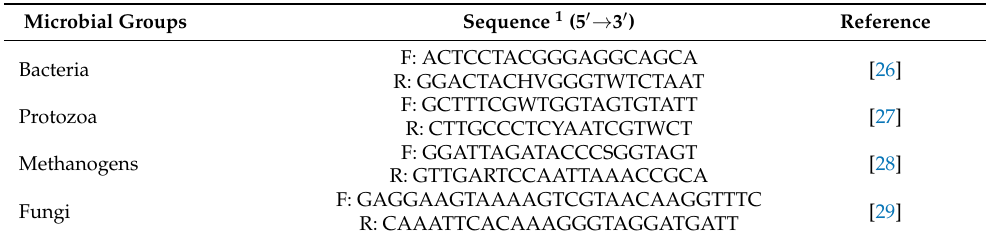
Table 3. The primers (forward and reverse) of the selected microbial groups for qPCR. Microbial